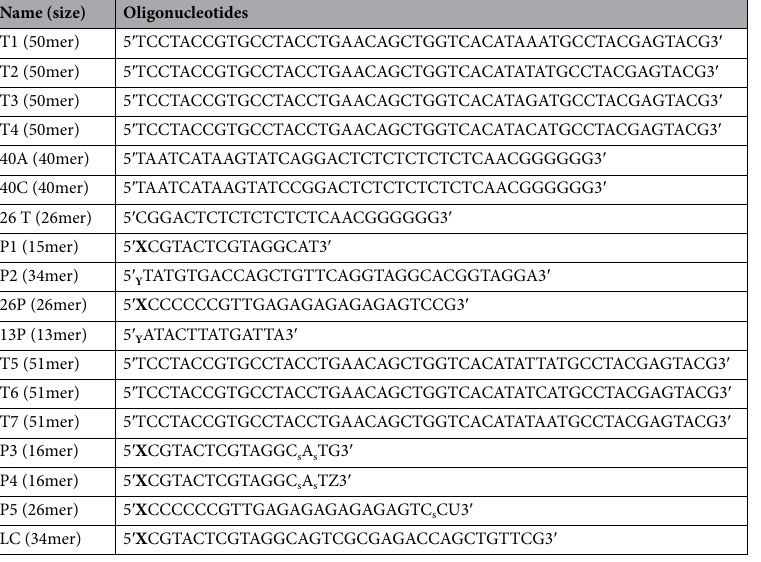
Table 2. Oligonucleotides used in this study are mentioned below in the table. The primers P3, P4, and P5 have phosphorothioate linkages between the mentioned nucleotides at 3 ′ end which are represented by subscript “s”. X, Y, and Z represent 6FAM, 5 ′ phosphate group, and 8oxodG, respectively.